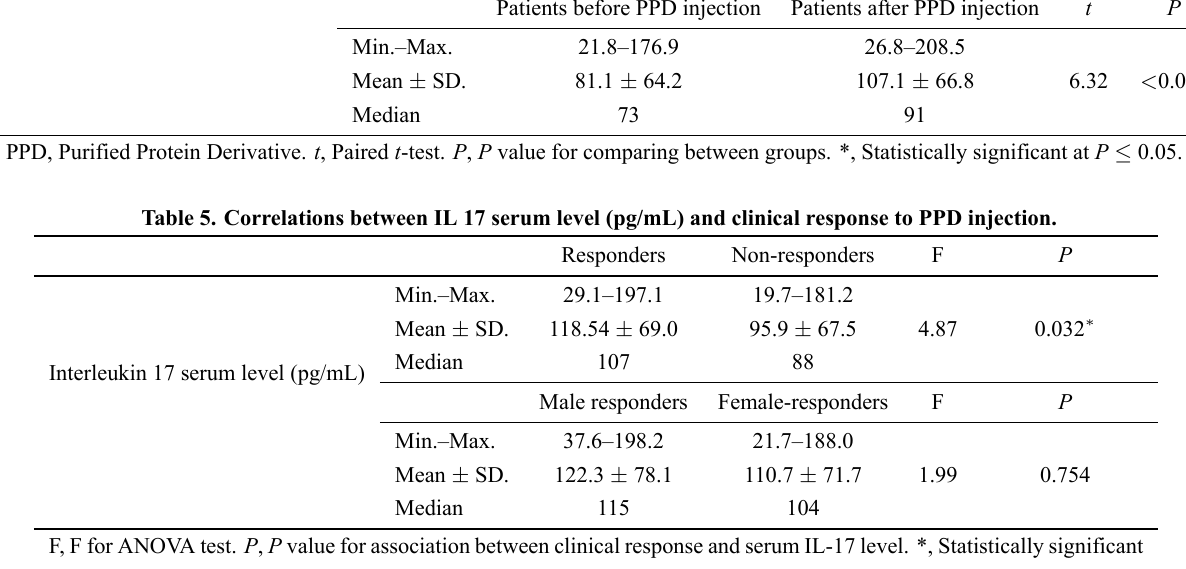
Interleukin 17 serum level (pg/mL)